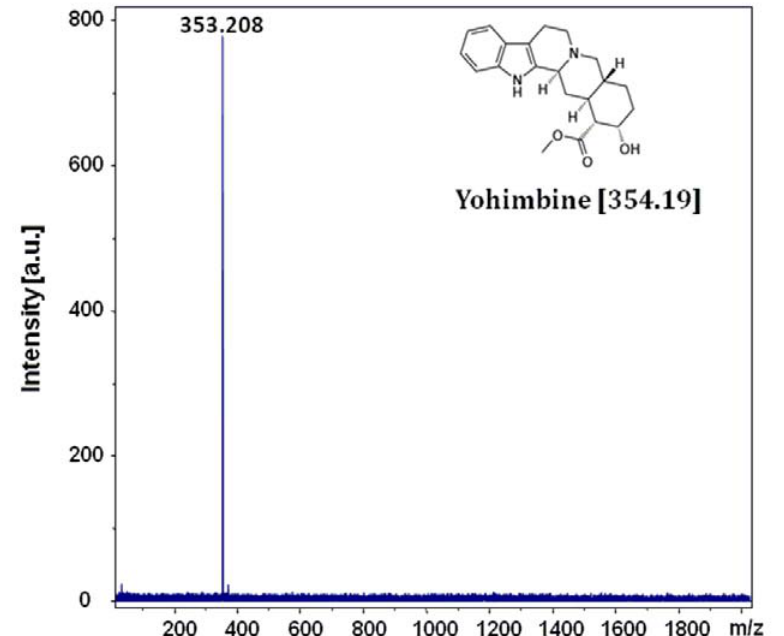
H N O calculated isotopic mass: 21 26 2 3